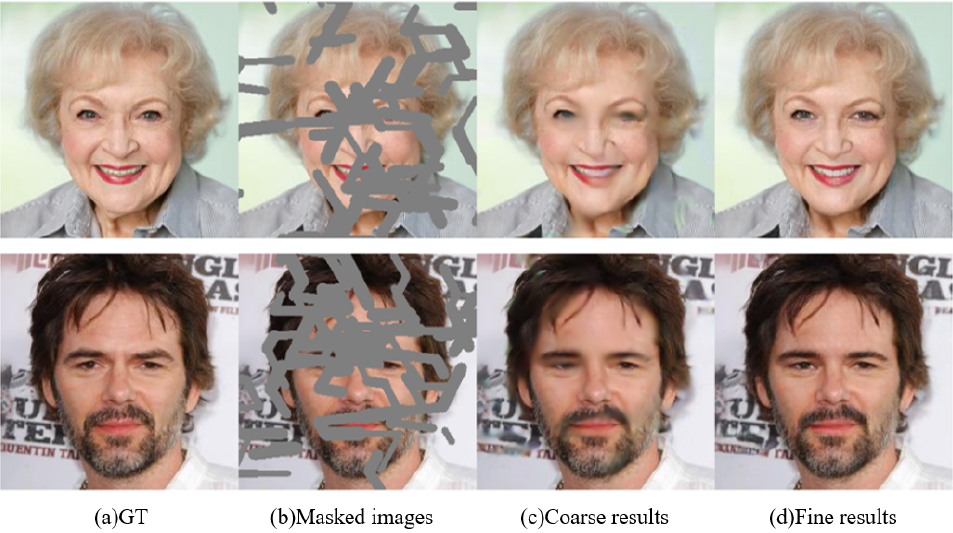
Figure 1. Completion results from coarse to